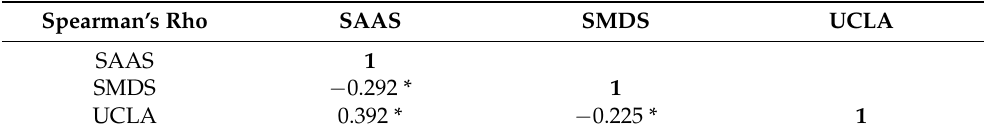
Table 3. Correlations between